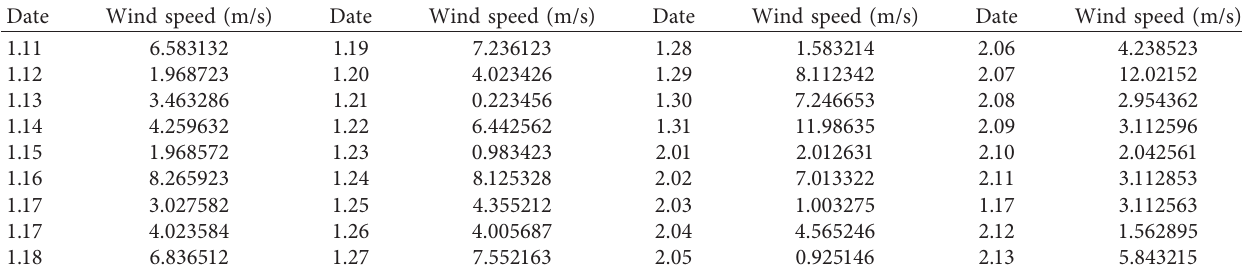
Table 14: Headwind component on runway.